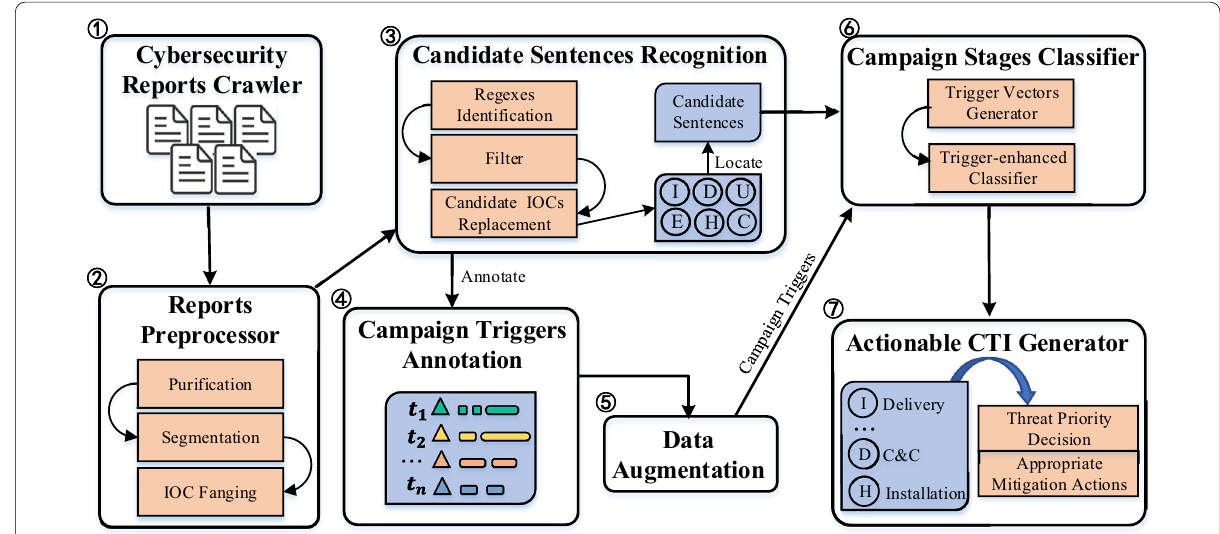
Fig. 2 The overall architecture of TriCTI system. IOC Types: IP address (I), Domain (D), URL (U), Email address (E), Hash (H), CVE number(C). t stands for campaign